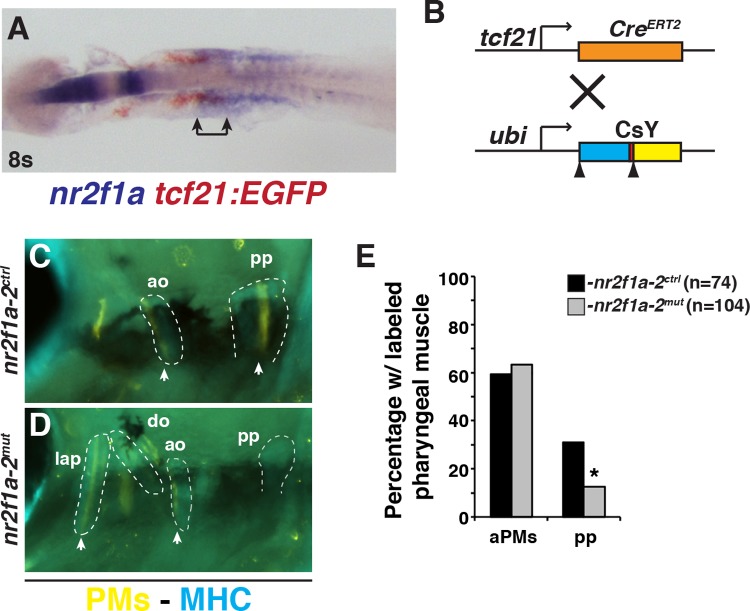
Tcf21+ progenitors less frequently contribute to the pp muscle in nr2f1a-2 mutant embryos.(A) Two-color ISH of nr2f1a (blue) and tcf21:EGFP (red). Embryo is flat-mounted with anterior leftward. Bracket indicates region of overlap. (B) Schematic of tcf21:CreERT2 recombinase and ubiquitous Cre-mediated color-switch transgenic lines used. (C, D) PMs (arrowhead) labeled in nr2f1a-2ctrl and nr2f1a-2mut embryos with the tcf21:CreERT2; ubi:CsY transgenes. Labeled PMs–yellow. Muscles (MHC)–blue. Outlines indicate PMs with labeled skeletal muscles. While other cells were labeled within the pharyngeal region, they were not scored as skeletal muscle because they were not located within the muscles or had morphology consistent with skeletal muscle. View is lateral with anterior to the left and dorsal up. (E) Percentage of labeled PMs on each side of the nr2f1a-2ctrl (n = 74) and nr2f1a-2mut (n = 104) embryos. The (n) reflects the total number of sides examined, since labeling was not equivalent on both side of an embryo. aPMs—anterior pharyngeal muscles, pp—protractor pectoralis. 44/74 nr2f1a-2ctrl and 66/104 nr2f1a-2mut had muscle labeled in aPMs. 23/74 nr2f1a-2ctrl and 13/104 nr2f1a-2mut had muscle labeled in the pp. Fisher’s exact test was used to determine if there was a difference between the frequency of anterior and posterior PMs in nr2f1a-2ctrl and nr2f1a-2mut embryos.